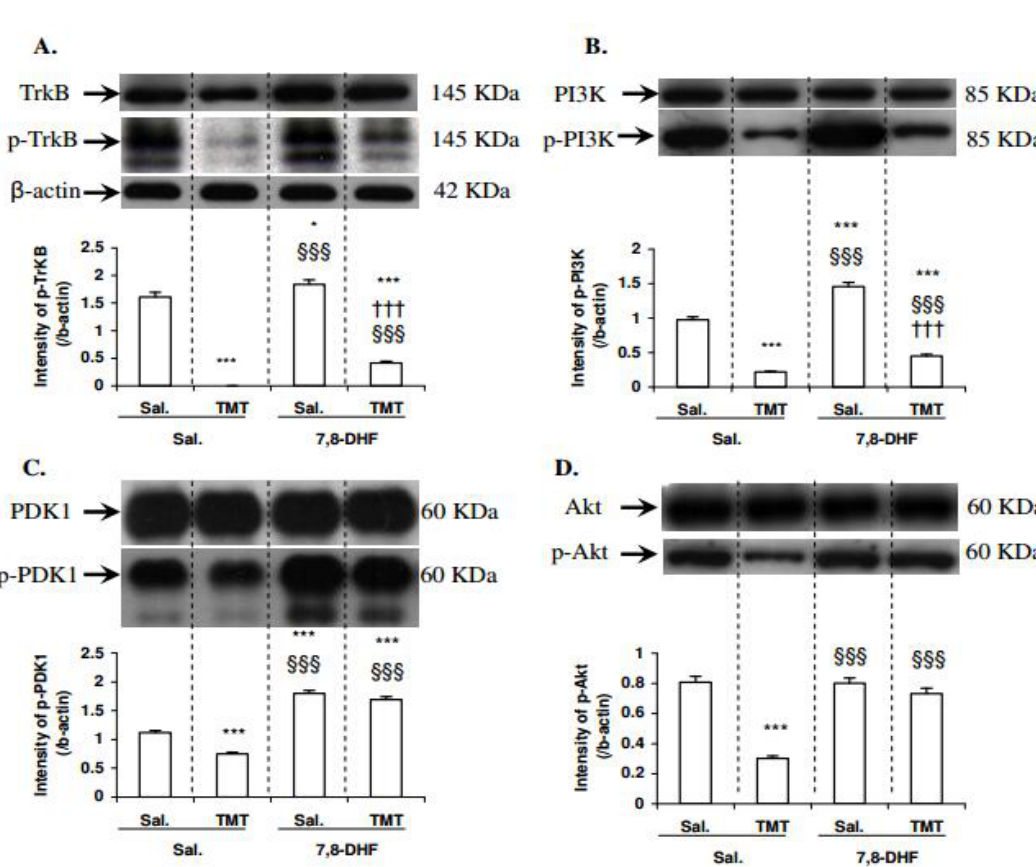
. Figure 2. The effects of 7,8-DHF on TMT-induced change in TrkB receptors, phospho-TrkA/B receptors (Figure 2A); in PI3K and phospho-PI3K (Figure 2B); in PDK1 and phospho-PDK1 (Figure 2C); in Akt and phospho-Akt (Figure 2D). Each value is expressed as the mean±S.E.M of six mice. * P <0.05, *** P <0.001 as compared to the saline-treated group; §§§ P <0.001 as compared to the 2d after TMT-treated group; ††† P <0.001 as compared to 7,8-DHF-treated group (The data was analyzed one-way ANOVA followed by Fisher's PLSD